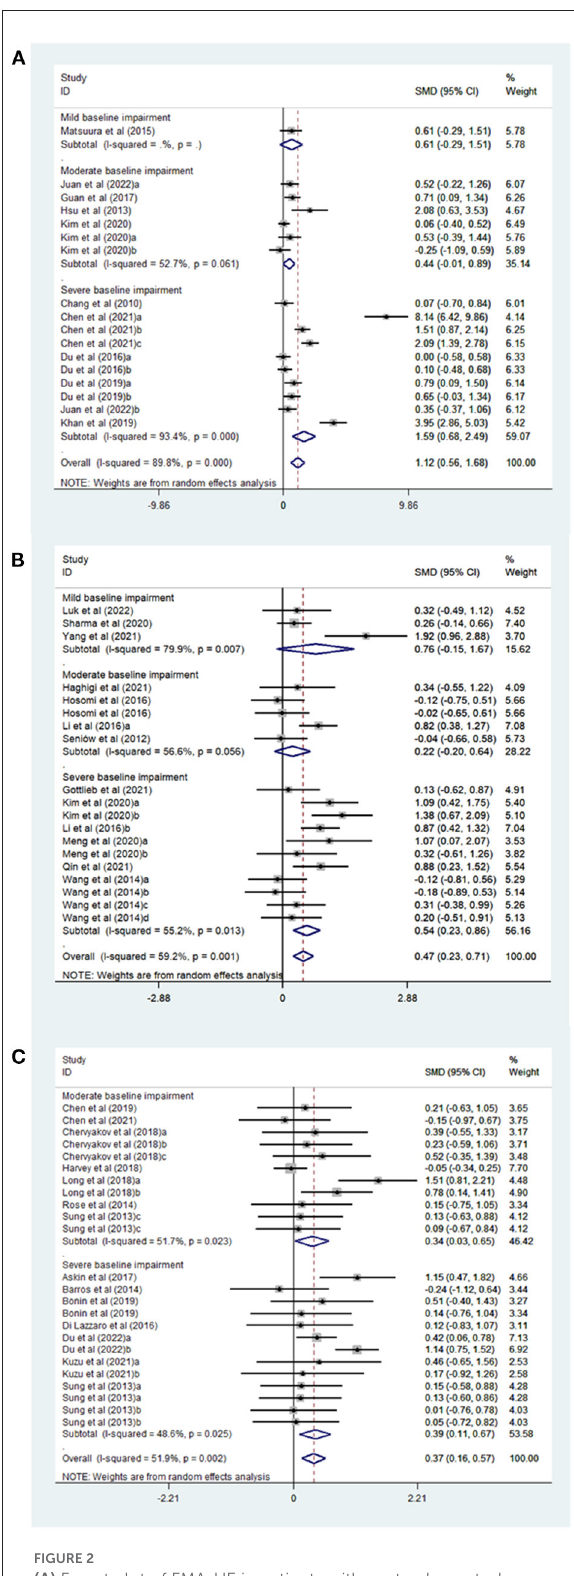
FIGURE2 (A) Forest plot of FMA-UE in patients with acute phase stroke disaggregated by baseline impairment level compared